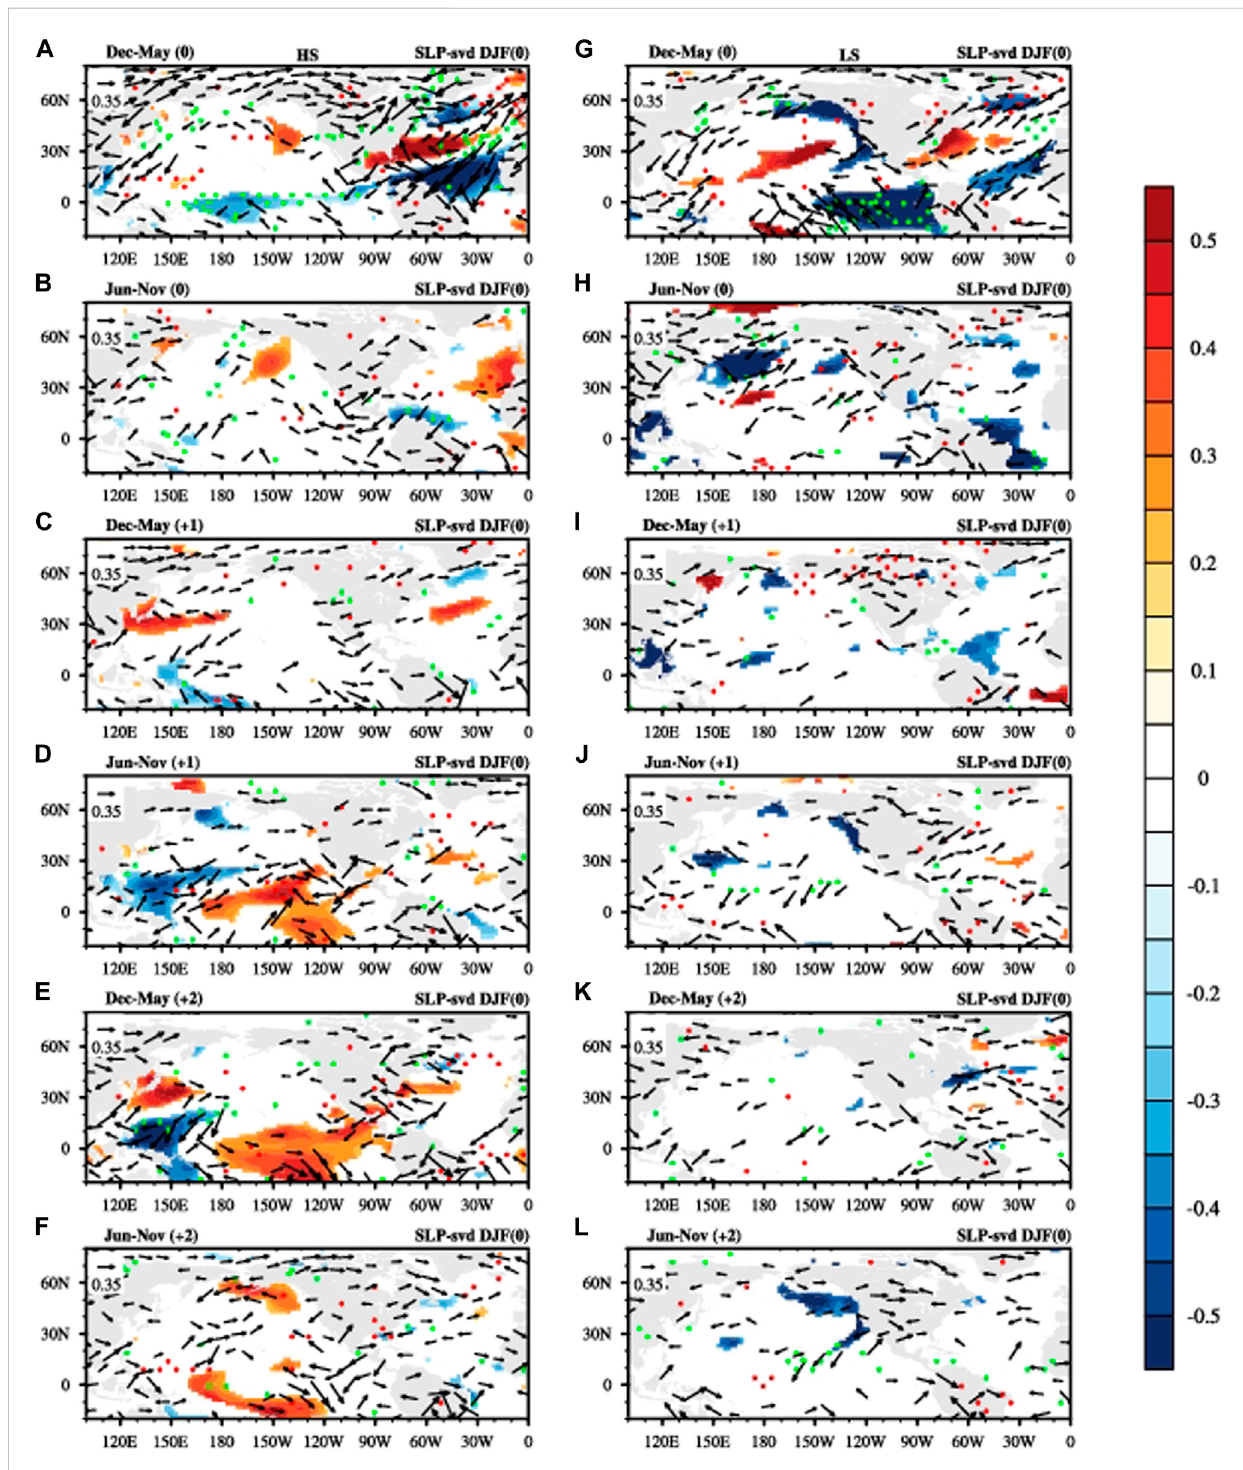
Left column: Lagged regression of the standardized SLP-svd time series onto the observed 6-month mean (December – May mean and June – November mean) SST anomalies (shading), surface wind anomalies (vectors), and precipitation rate anomalies (stippled red (positive) and green (negative)) in the same year (A,B) , lagged 1 year (C,D) and lagged 2 years (E,F) in the HS subset. Right column: (G – L) is the same as (A – F) , but for the LS subset. For all the variables, only the values above the 90% signi fi cance level are shown. Please notice, here we took December of last year as the beginning of the winter season of the current